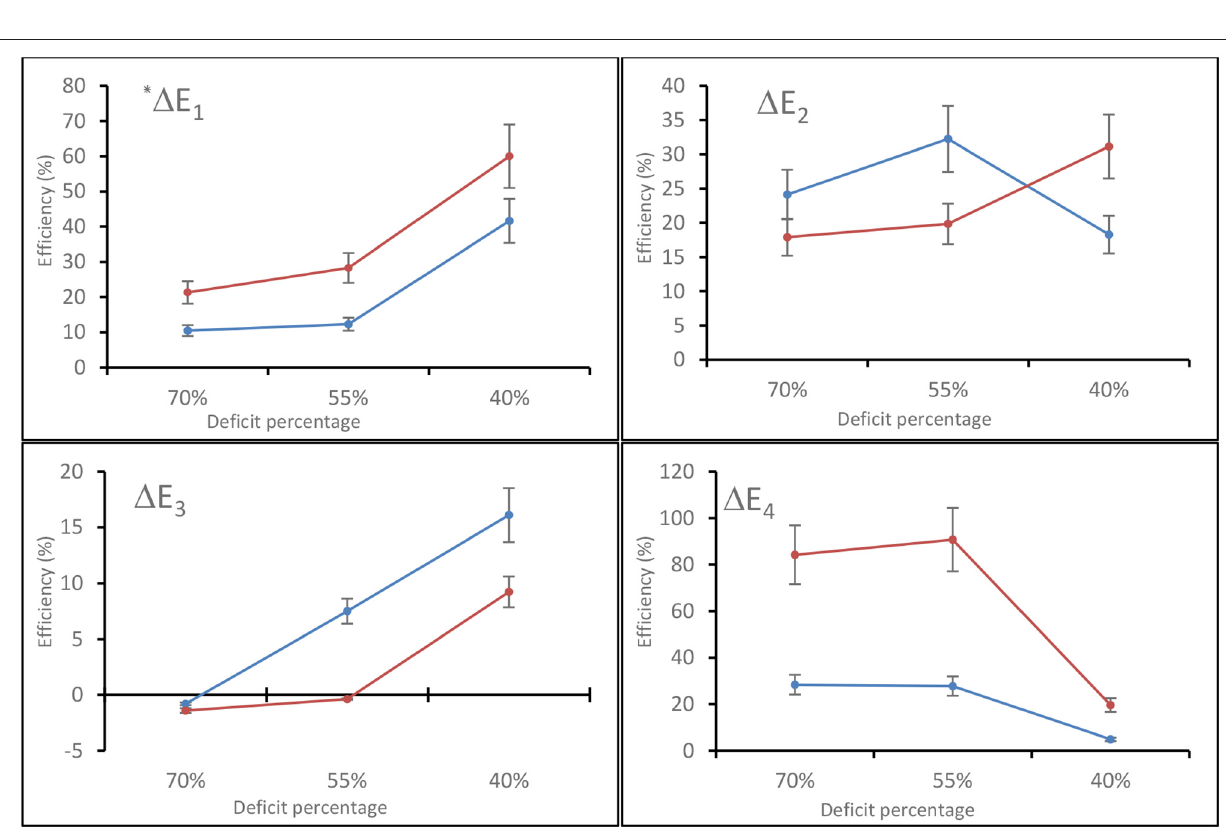
Frontiers in Water |